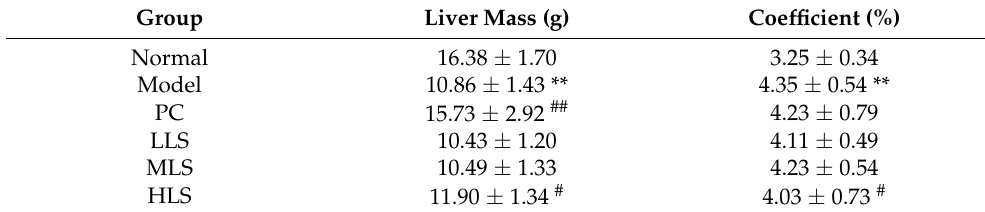
Table 1. Effect of LS oral administration on liver mass and liver coefficient of T2D